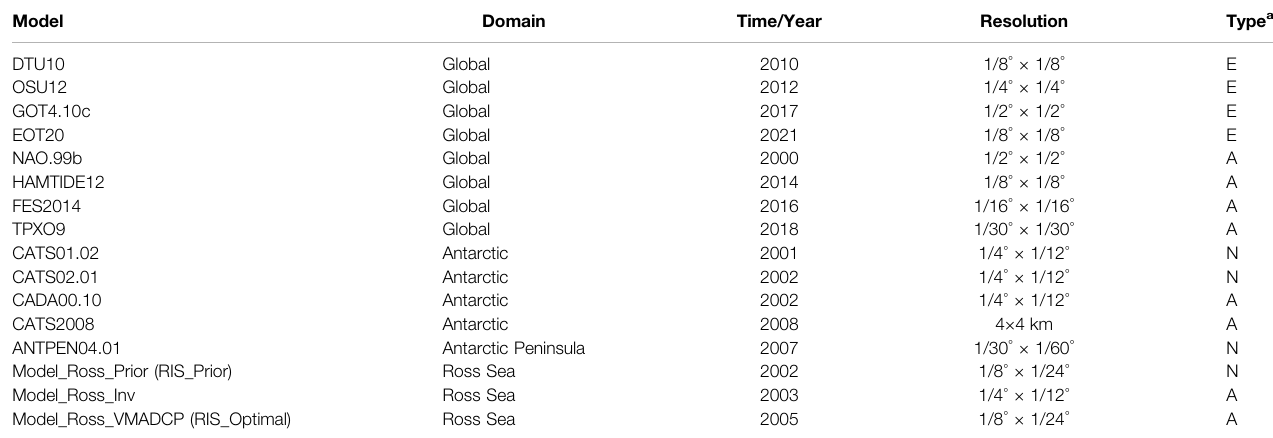
TABLE 1 | Summary of ocean tide